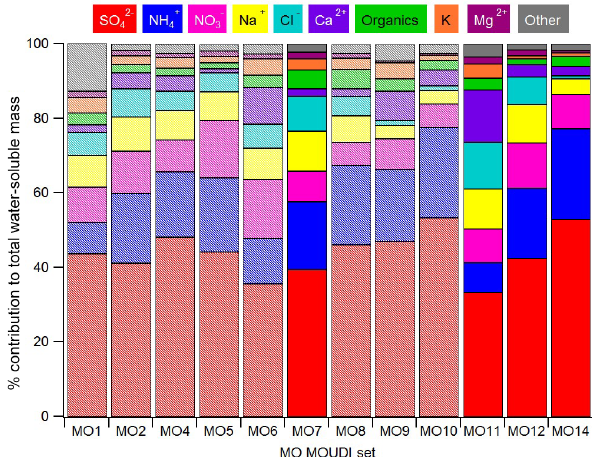
Figure 6. Percent contribution of various species to the total water- soluble mass concentration for each of the 12 sample sets. The sam- ple sets with the three highest aerosol concentrations (MO7, MO12, and MO14) and the lowest aerosol concentration (MO11) are shown as solid bars while all other sample sets are stripes. The “organics” category contains the sum of methanesulfonate (MSA), pyruvate, adipate, succinate, maleate, oxalate, and phthalate.